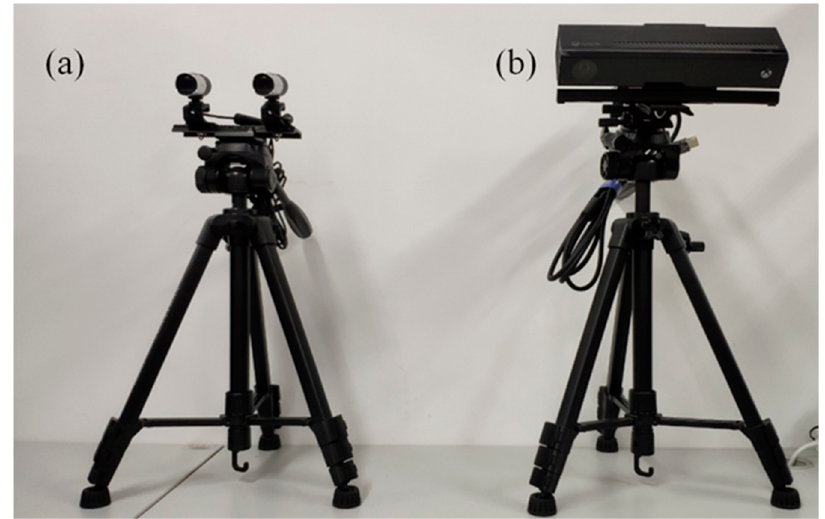
Figure 1. Two types of imaging sensors with tripods: ( a ) shows the binocular stereo vision system used in this research; ( b ) shows a Kinect V2 sensor mounted on a tripod.